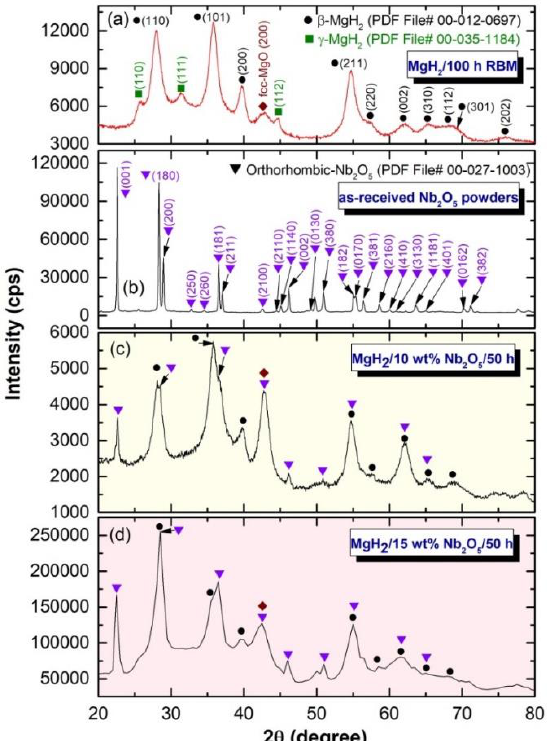
Figure 5. XRD patterns of ( a ) Mg flakes obtained after 100 passes of CR followed by 100 h RBM and ( b ) as-received Nb 2 O 5 catalytic powders. The XRD patterns of as-CR MgH 2 after RBM for 100 h and then mechanically ball-milled for 50 h with 10 wt.% and 15 wt.% of Nb 2 O 5 are displayed in ( c ) and ( d ), respectively.